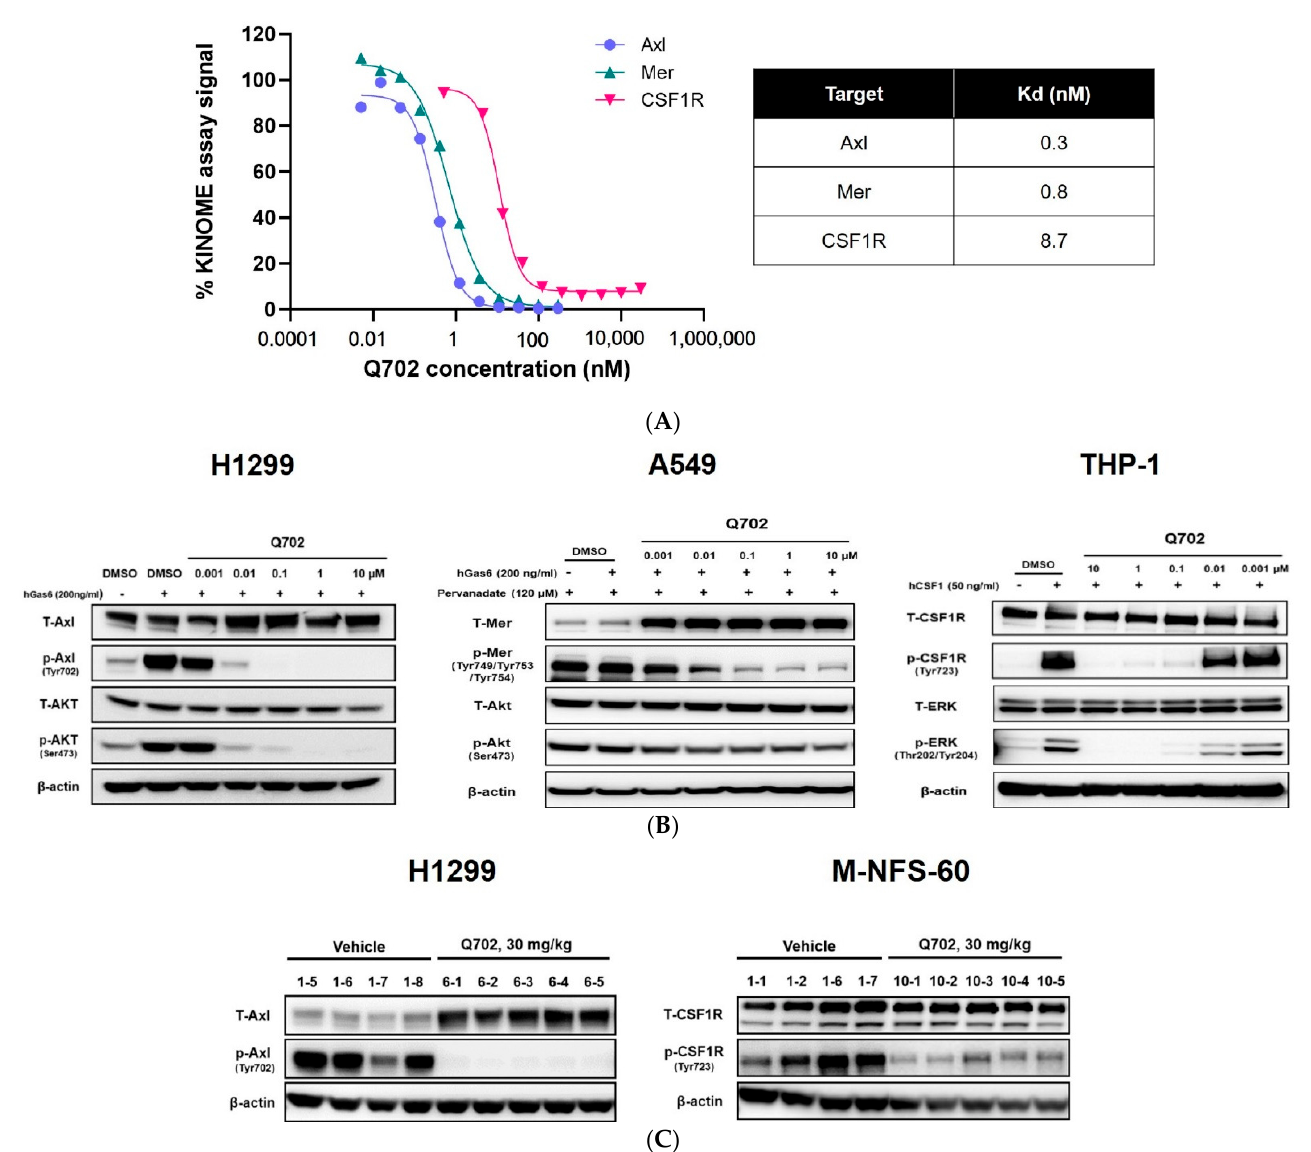
Figure 1. Q702 markedly inhibits the activation of Axl, Mer, and CSF1R in various in vitro and in vivo systems. ( A ) LanthaScreen equilibrium binding and biochemical binding assessment for the Kd for Axl, Mer, and CSF1R was performed. ( B ) H1299, A549, and THP-1 cells were treated with 200 ng/mL human Gas6 or 50 ng/mL human CSF1 in the presence of Q702. Cells were lysed, and the cell lysates were probed for phosphorylation of Axl (Tyr702), AKT (Ser473), Mer (Tyr749/Tyr753/Tyr754), CSF1R (Tyr723), or ERK (Thr202/Tyr204). ( C ) H1299 (5 × 10 6 ) cells or M-NFS-60 (1 × 10 6 ) cells were inoculated subcutaneously into the left flank of BALB/c nude mice. When the tumor size reached 200 − 300 mm 3 , mice were randomized and treated with vehicle or Q702 (30 mg/kg) orally once daily for one week. Tumors were lysed, and the tumor lysates were probed for phosphorylation of Axl (Tyr702) and CSF1R (Tyr723). T-Axl, total Axl; p-Axl, phosphorylated Axl; T-AKT, total AKT; p-AKT, phosphorylated AKT; T-Mer, total Mer; p-Mer, phosphorylated Mer; T-CSF1R, total CSF1R; p-CSF1R, phosphorylated CSF1R; T-ERK, total ERK; p-ERK, phosphorylated ERK. Original Wester blot images can be found in Figure S3 – S7.